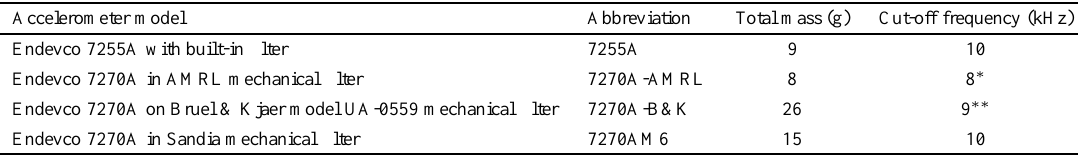
Summary of characteristics of accelerometer and mechanical filter